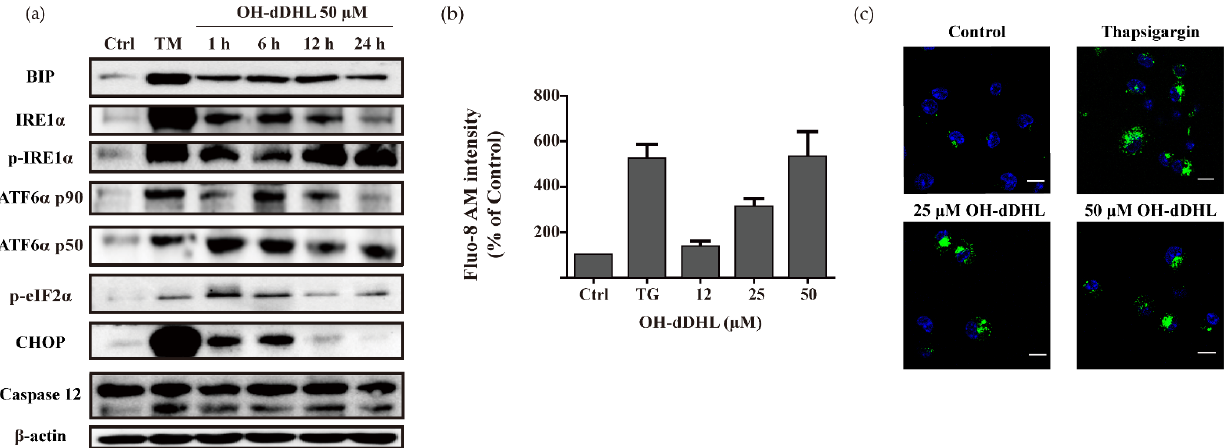
Figure 4. OH-dDHL-induced apoptosis through ER stress. ( a ) BMDMs were treated with 50 µM OH-dDHL in a time- dependent manner. All signal molecules were analyzed using Western blot. Tunicamycin (TM) was used as a positive control. Ctrl; negative control. ( b ) BMDMs were stained with Fluo-8 AM for 1 h and treated with OH-dDHL in a dose-dependent manner. The fluorescence signals were measured at Em = 520 nm. Thapsigargin (TG) was used as a positive control. Data are presented as mean ± SEM of three independent experiments. ( c ) BMDMs with OH-dDHL for 1 h were incubated with Fluo-8 AM in HBSS (Hanks ’ Balanced Salt Solution) at 37 °C, 5% CO 2 incubator for 1 h and were imaged with a confocal microscope using the FITC channel. Scale bar, 10 µm.